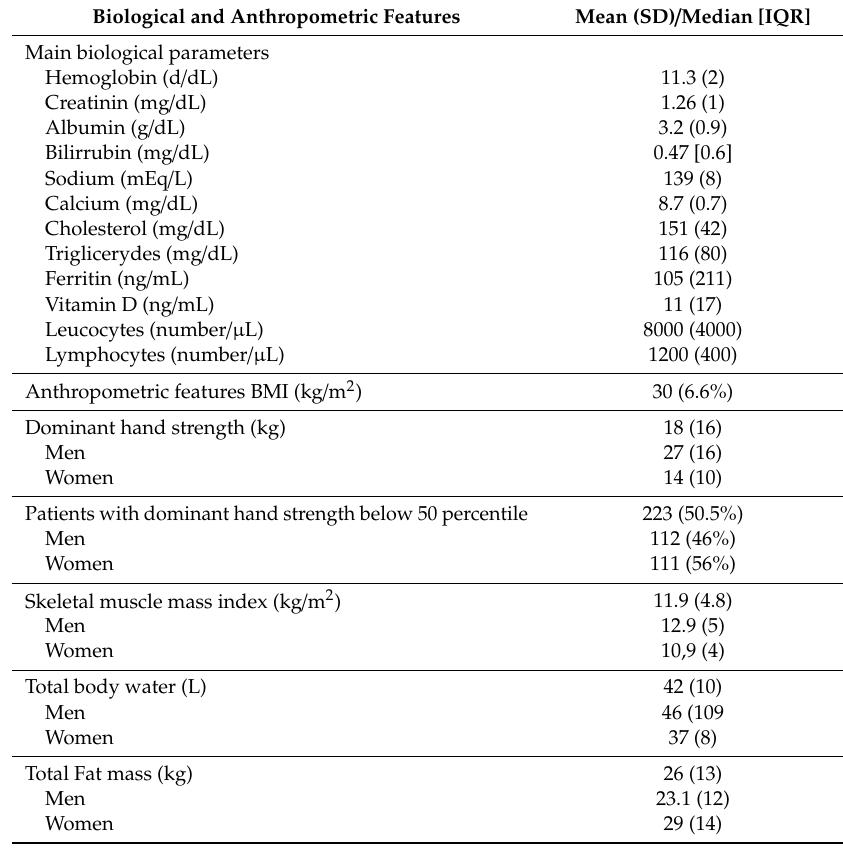
Table 3. Main biological and anthropometric parameters of a multicenter sample of 444 polypathological patients recruited for sarcopenia and frailty